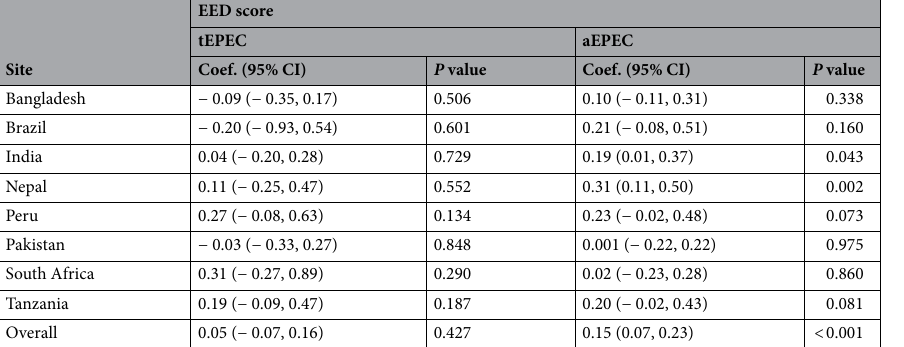
Table 4. Association between the genomic subtypes of EPEC and enteric inflammation (EED score: stool Myeloperoxidase, Neopterin, and Alpha-1-Antitrypsin). The dependent variable was log (MPO, NEO, and ALA); Independent variables: the presence of virulence-related genes associated with EPEC at each month. Adjusted in GEE model for sex, age, WAMI Index (water/sanitation, assets, maternal education, and income); enrollment length-for-age z score; maternal BMI; the number of children, poultry/cattle in house, seasonality, serum zinc level, AGP (alpha-1-acid glycoprotein), presence of co-pathogens ( Campylobacter, LT-ETEC, ST-ETEC, Shigella, and Giardia ), site for the overall estimate, and age as the time variable. EED score ( AAT alpha-1-anti-trypsin, MPO myeloperoxidase, NEO neopterin). Coef. Coefficient, CI confidence interval.